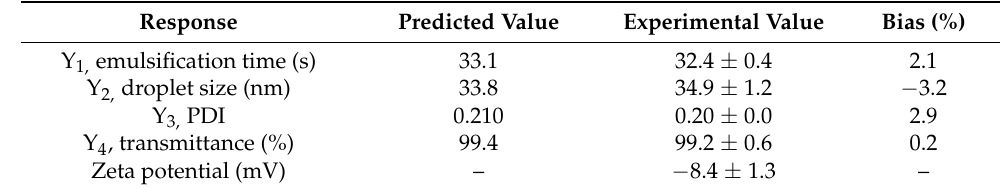
Figure 4. Mixture profiler of the isotropic blend prepared as per the D-optimal design. Prediction formula for the following: green, emulsification time (Y 1 ); blue, droplet size (Y 2 ); red, PDI (Y 3 ), brown, transmittance percentage (Y 4 ); white, optimum area. Table 5. The predicted values and experimental results of F1 prepared under optimum